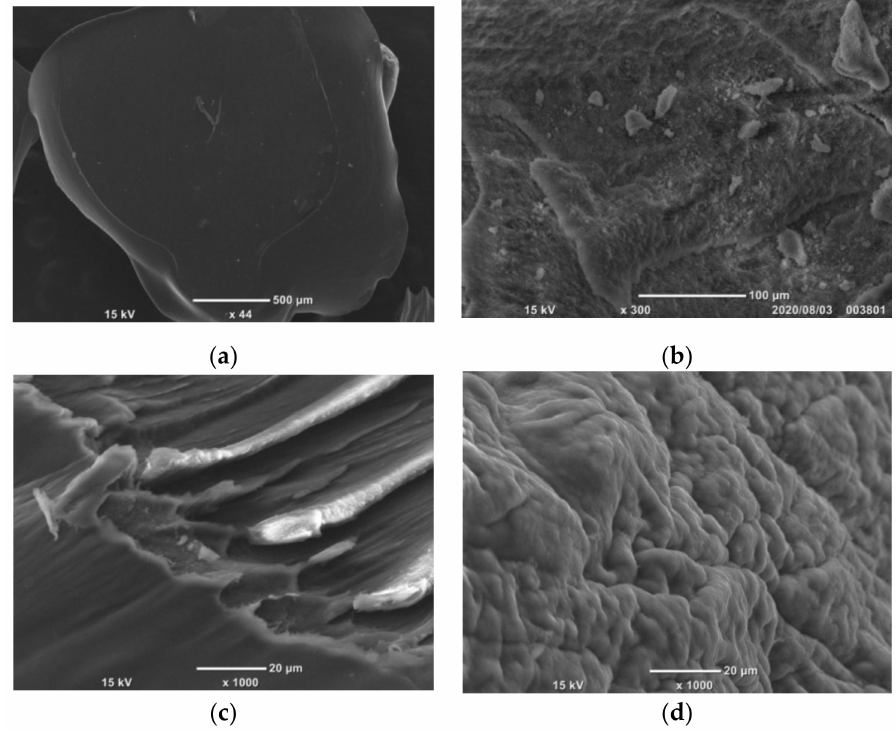
Figure 3. SEM images of ( a , c ) chitosan, ( b ) ZIF-8, and ( d )